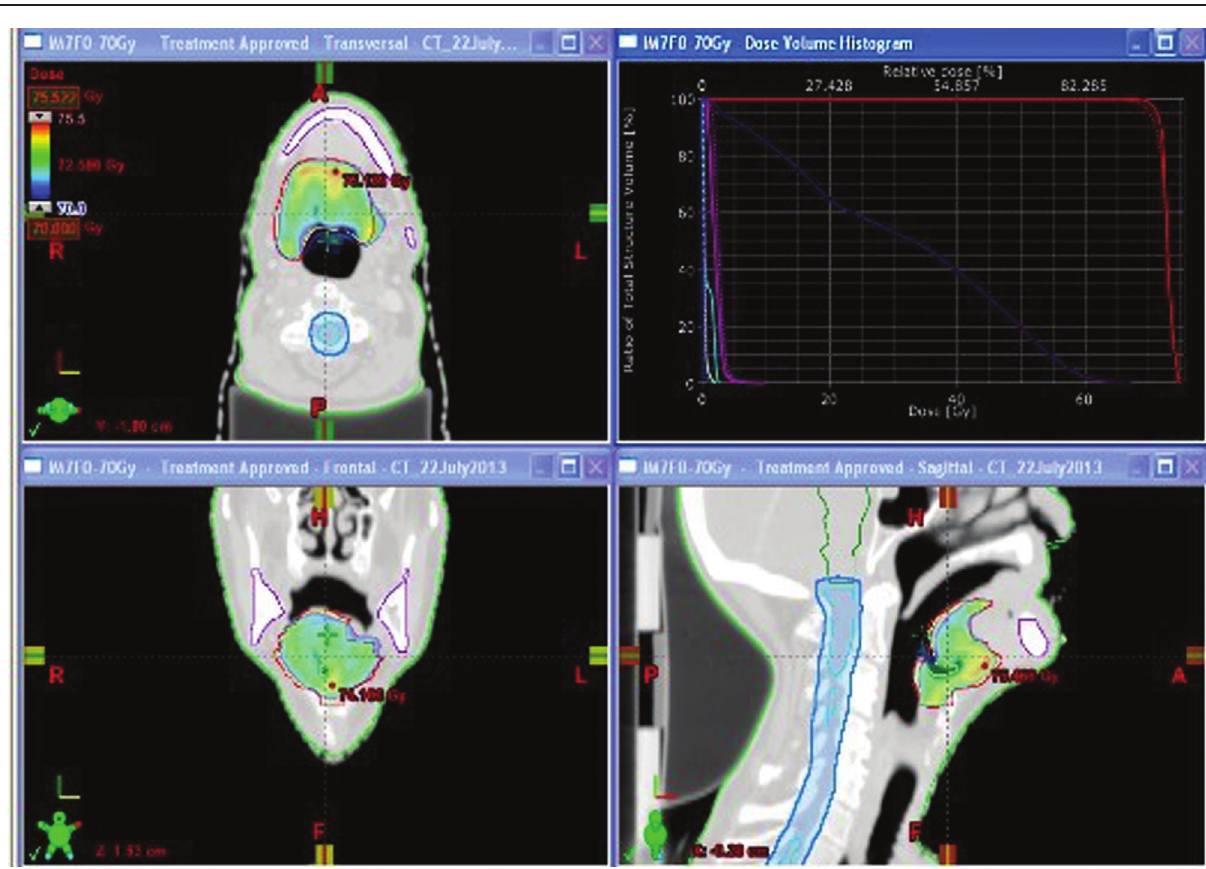
Inverse planning intensity-modulated radiotherapy